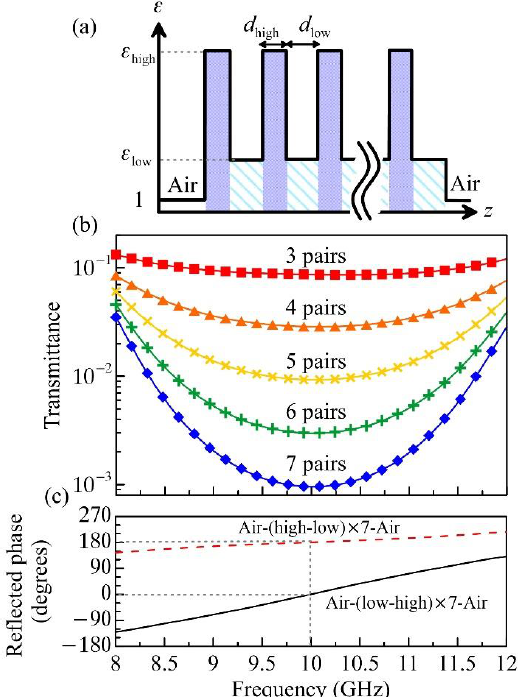
Figure 5. ( a ) Permittivity profile of Bragg total reflection coating. ( b )Transmittance of Bragg coating made of alternating 25 vol. % BTEP nanocomposite and pure epoxy layers. The simulation results are plotted in symbols. ( c ) Reflected phases of the Bragg coatings with high – low – high (red dashes) and low – high – low (black) layer orders.